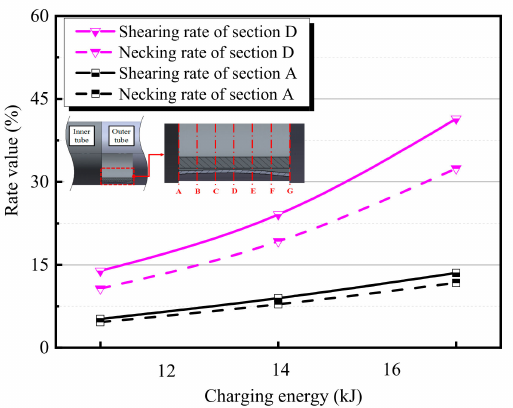
Figure 12. Comparison between shearing and necking rate of positions A and D under different charging